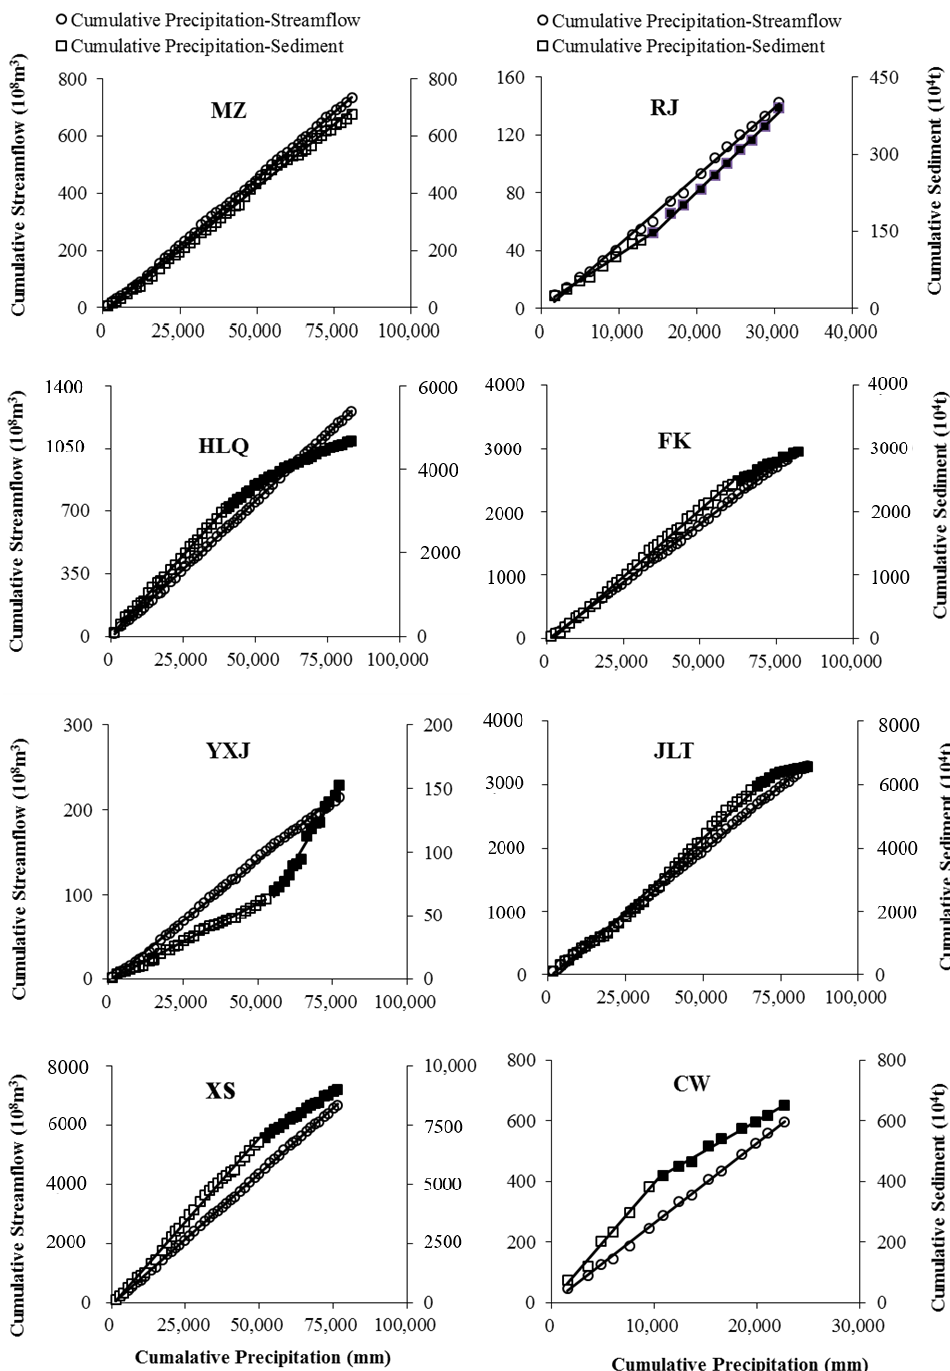
Figure 4. Double mass curves of precipitation-streamflow and precipitation-sediment of eight hydrological stations with sediment data on the Gongshui River basin. Note: MZ, RJ, FK, HLQ, YXJ, JLT, XS, and CW are abbreviations for Mazhou, Ruijin, Fenkeng, Hanlinqiao, Yangxinjiang, Julongtan, Xiashan, and Chawu, respectively. (cid:4) means the values of cumulative Precipitation-Sediment after the corresponding change